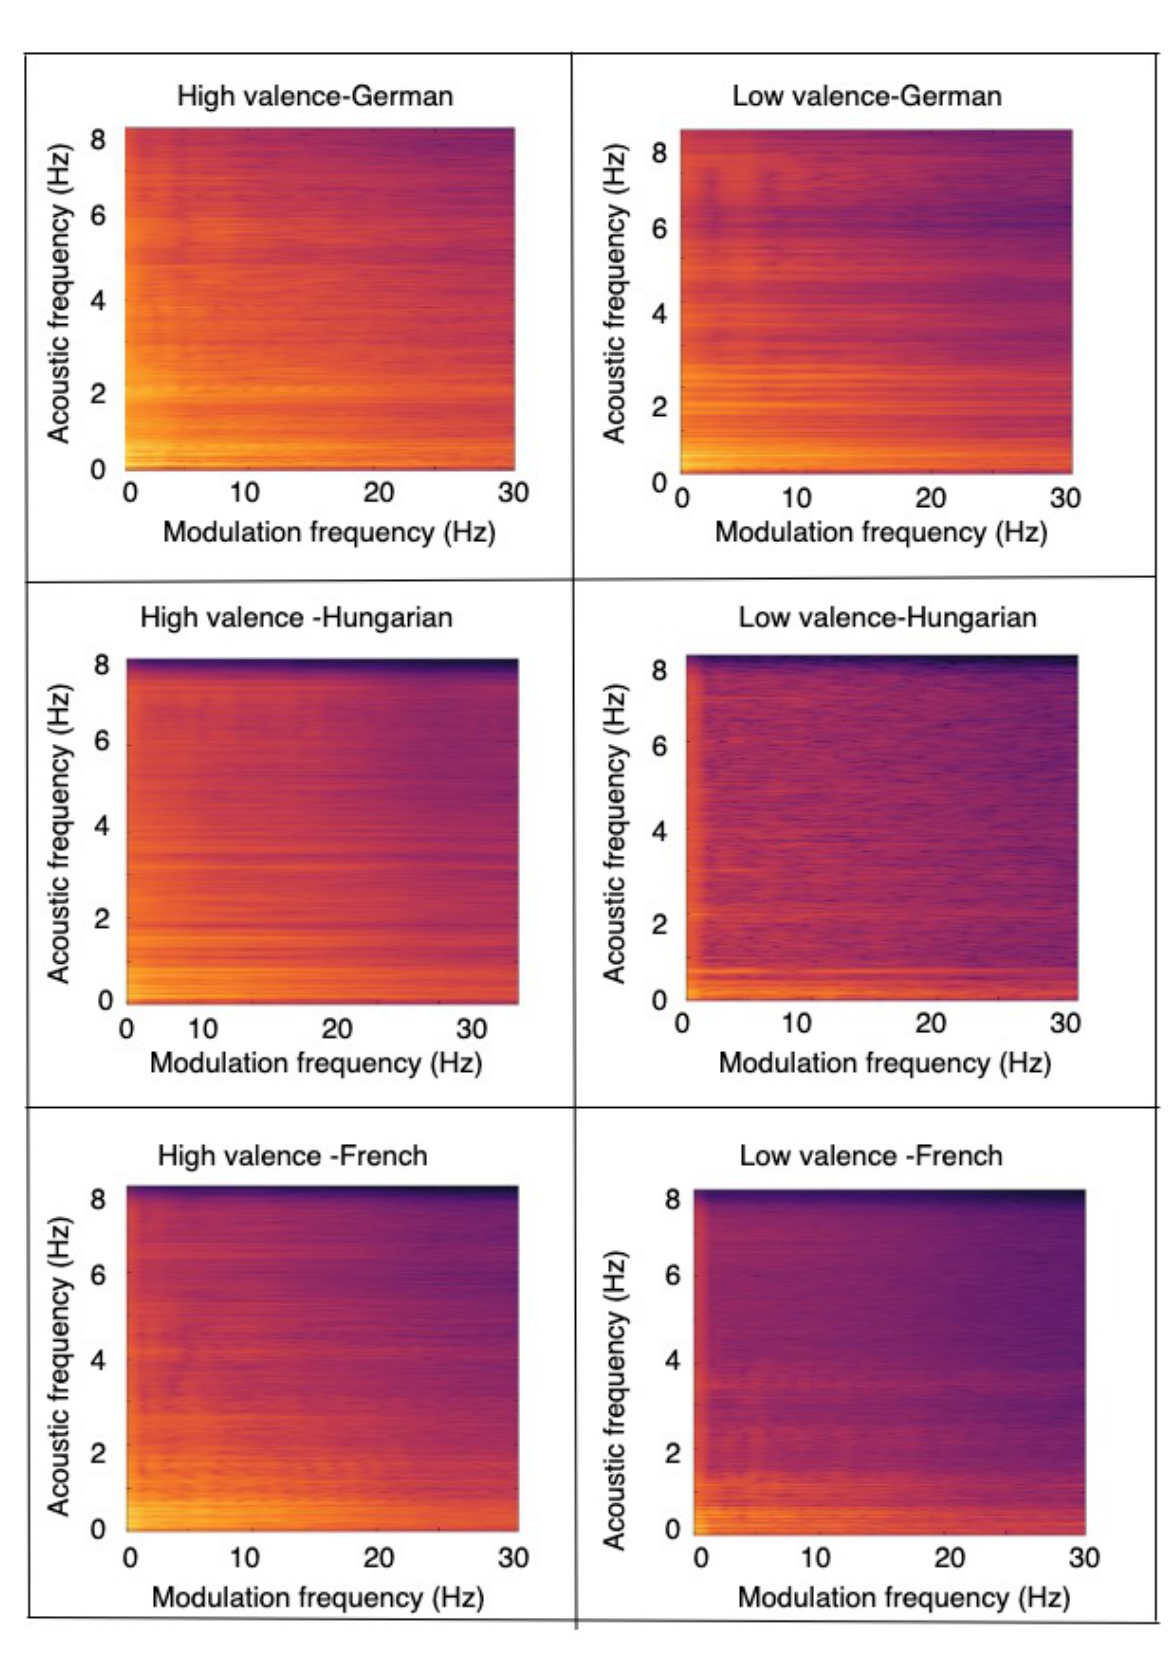
Figure 6. Average modulation spectrogram for German (top), Hungarian (middle), and French (bottom) language for high-(left) and low-(right) valence